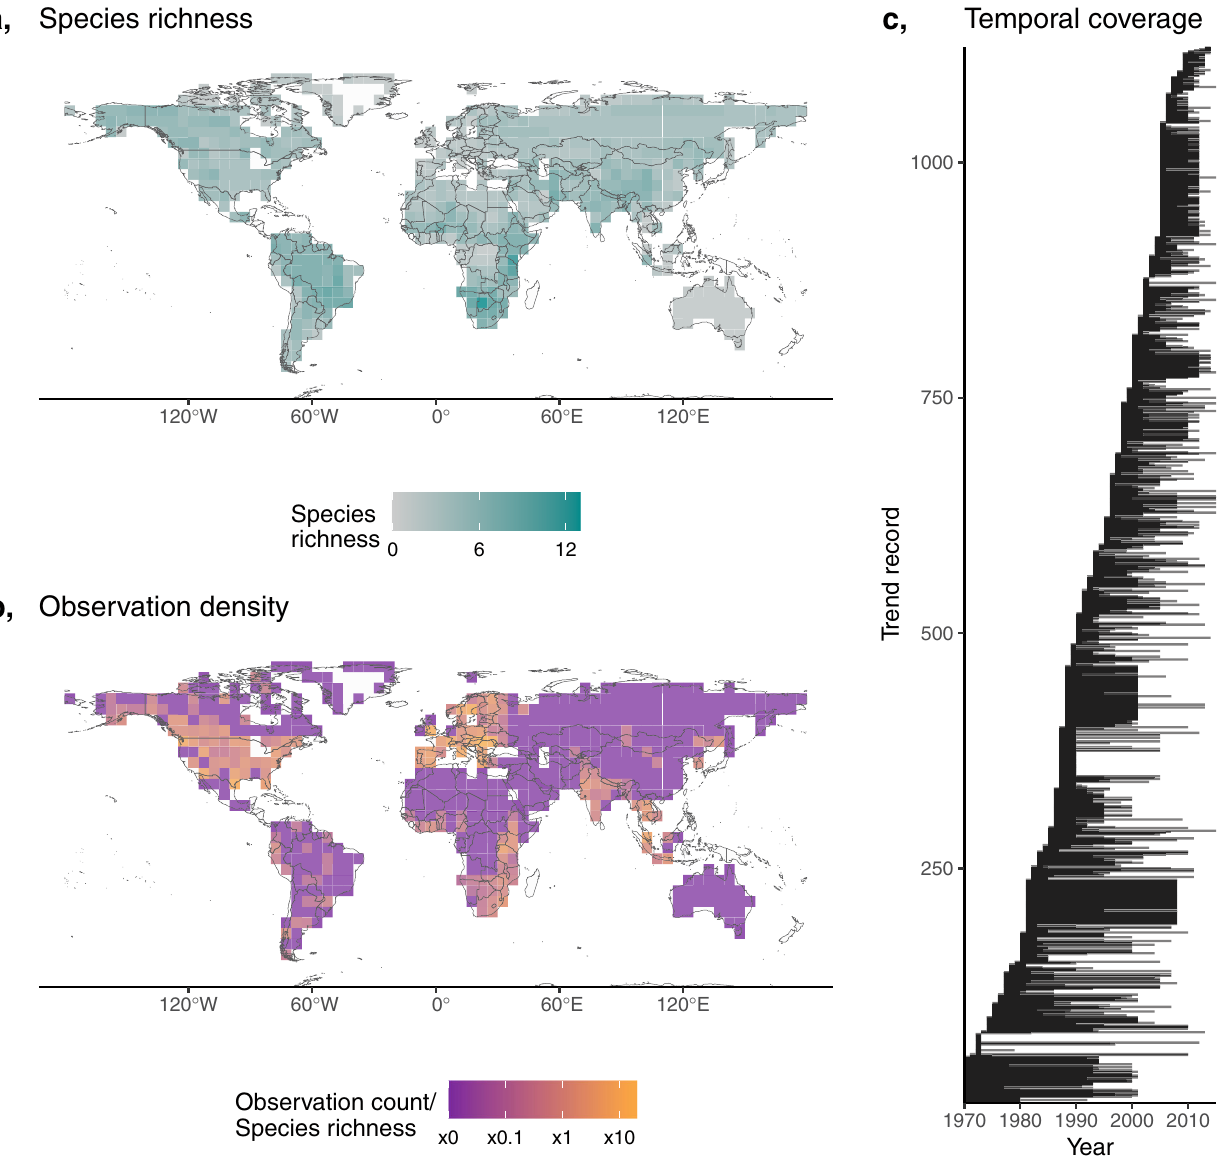
Fig.1 |Distributionofcarnivoredata.a Speciesrichnessof largecarnivoresfrom the families Canidae, Felidae, Hyaenidae and Ursidae of the order Carnivora. Spe- ciesrichnessderivedby fi ndingthesumofeachspecies( N =87)currentIUCNrange maps (terrestrial-extant range only, so excluding locations the species is now extinct). For instance, a value of 10 indicates that 10 large carnivore species are suspected to occur within this 5-degree cell according to IUCN range maps. b The